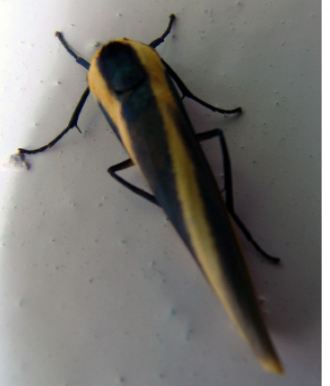
Image 23. Chrysorabdia bivitta (Walker) (Erebidae)